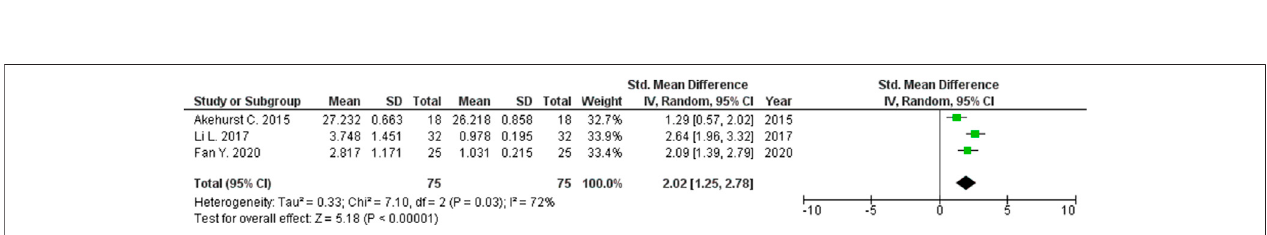
FIGURE 3 | Meta-analysis of differences in expression level of miRNA-20b in placenta between women with vs. without preeclampsia.